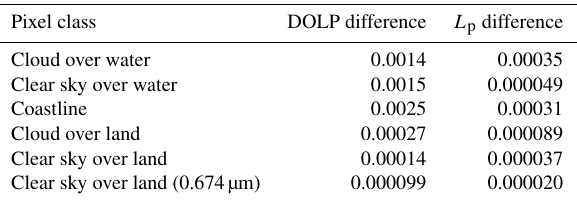
Table 7. The medians of degree of linear polarization (DOLP) dif- ference and polarized normalized radiance ( L p )